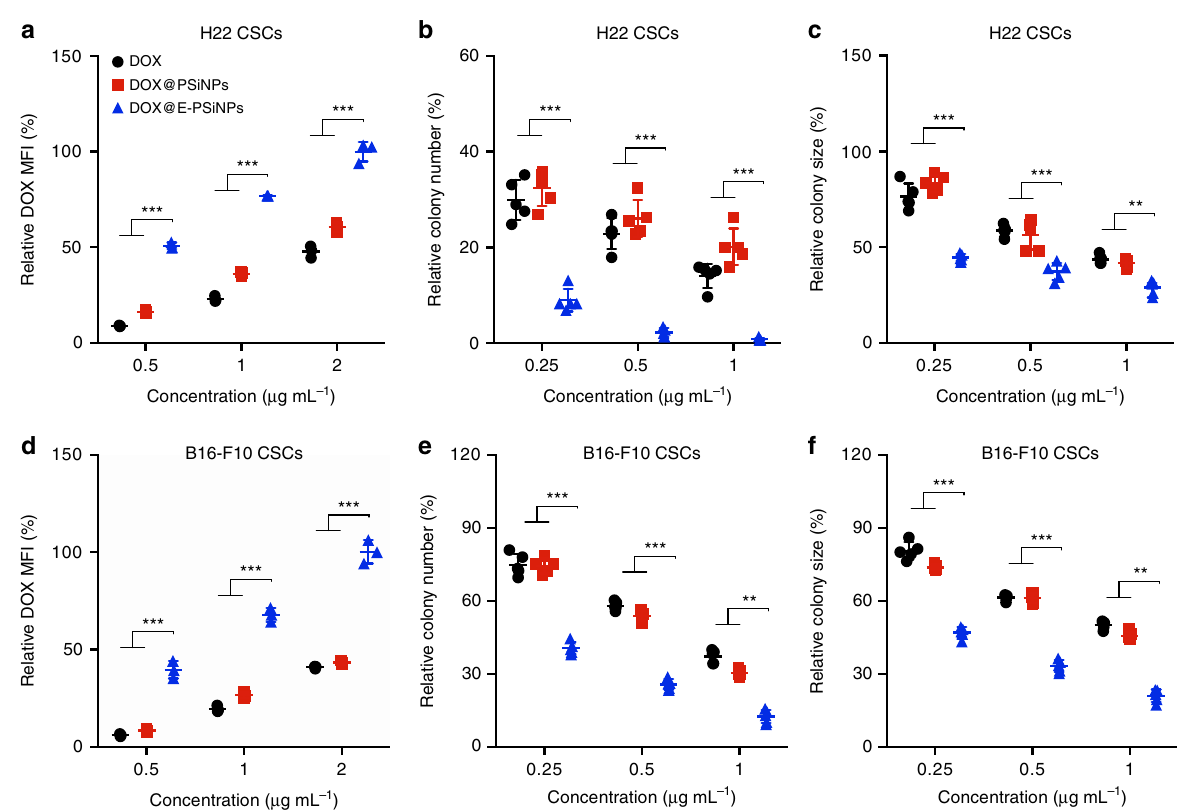
Fig. 5 Cellular uptake and cytotoxicity of DOX@E-PSiNPs against CSCs. a , d Relative DOX mean fl uorescence intensity (MFI) when H22 CSCs ( a ) and B16- F10 CSCs ( d ) selected in soft 3D fi brin gels were treated with free DOX, DOX@PSiNPs or DOX@E-PSiNPs exocytosed from H22 cells at different DOX concentrations for 2 h by fl ow cytometry. Data were represented as mean ± SD ( n = 3). b , e Relative colony number of tumor spheroids when H22 ( b ) and B16-F10 cells ( e ) were pretreated with free DOX, DOX@PSiNPs or DOX@E-PSiNPs exocytosed from H22 cells at different DOX concentrations for 4 h and then seeded in soft 3D fi brin gels for 5 days. c , f Relative colony size of tumor spheroids when H22 ( c ) and B16-F10 cells ( f ) were pretreated with free DOX, DOX@PSiNPs or DOX@E-PSiNPs exocytosed from H22 cells at different DOX concentrations for 4 h and then seeded in soft 3D fi brin gels for 5 days. Data were represented as mean ± SD ( n = 5). ** P < 0.01, *** P < 0.001 (two-way ANOVA with Bonferroni ’ s multiple comparisons test). Source data are